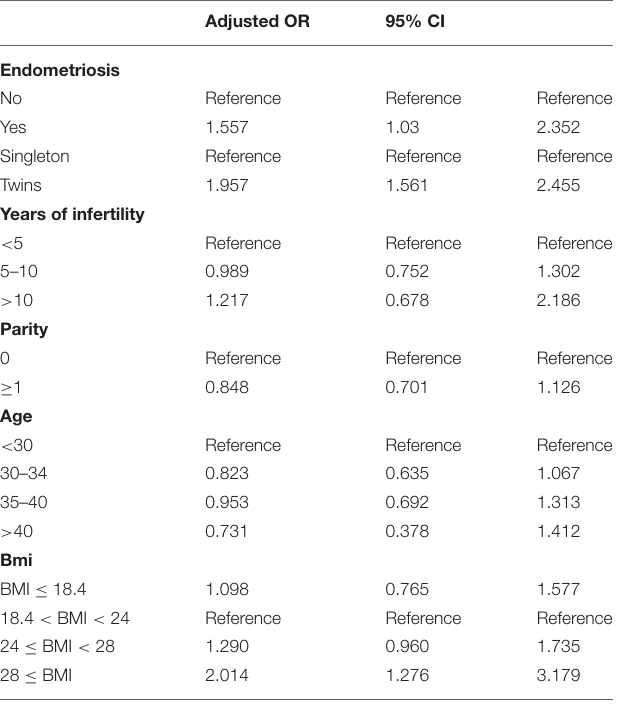
TABLE 5 | Logistic regression for factors influenced congenital